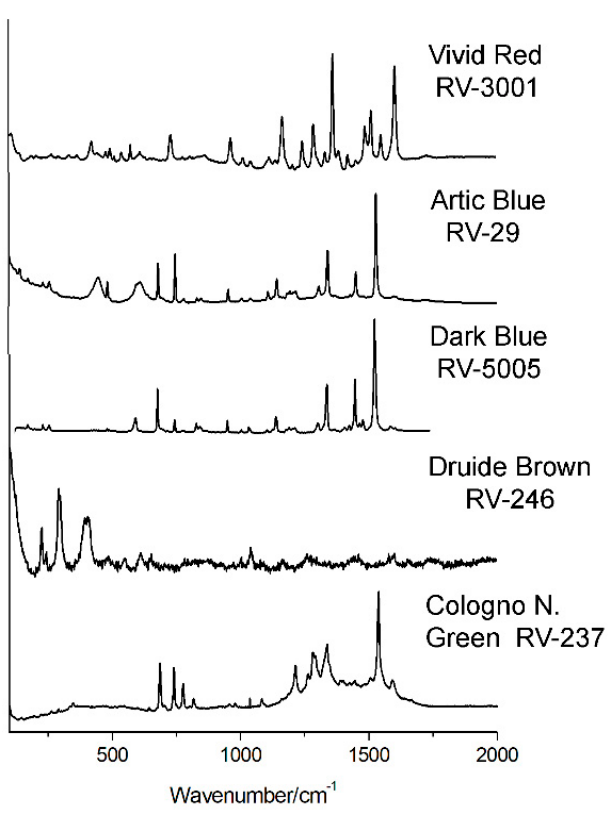
Figure 3. Raman spectra of the commercial sprays of the Montana brand.